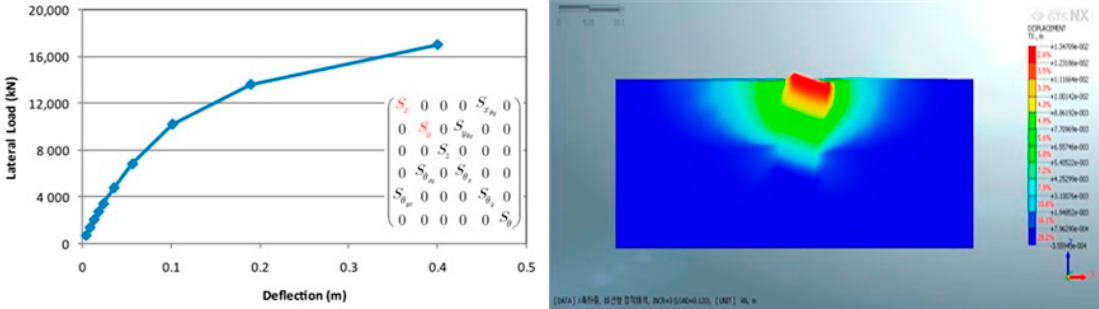
19 of 26 Figure 16. Evaluation of stiffness matrix of suction pile ( example of 𝐹 (cid:3051) - 𝛿 (cid:3051) , 𝐹 (cid:3052) - 𝛿 (cid:3052) )